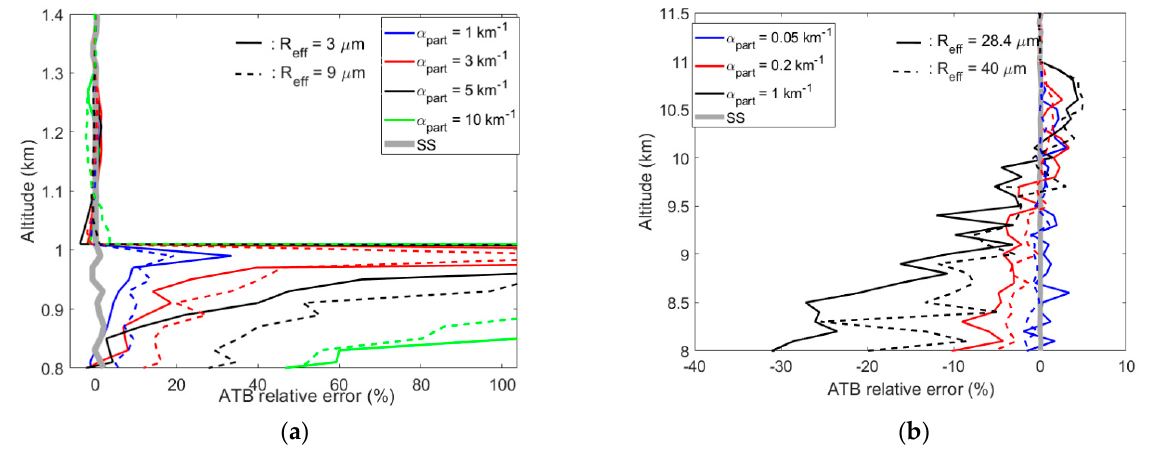
Figure 6. Vertical profiles of the relative error (in %) between the ATB computed by BLISS and McRALI in the single (grey curves) and multiple-scattering regime. ( a ) Stratocumulus clouds with R ef f = 3 µ m (full curves) and R ef f = 9 µ m (dotted curves). Stratocumulus extinction α part is 1 km − 1 (blue), 3 km − 1 (red), 5 km − 1 (black), and 10 km − 1 (green). ( b ) Cirrus cloud with R ef f = 28.4 µ m (full curves) and R ef f = 40 µ m (dotted curves). Cirrus extinction α part is 0.05 km − 1 (blue), 0.2 km − 1 (red) and 1 km − 1 .